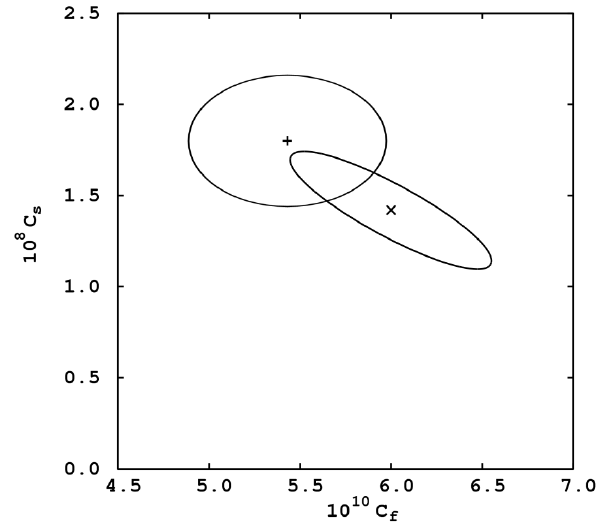
Figure A1. C s vs. C f for the R98 model ( + ) and its modification by Turner et al. (2009) ( × ), with uncertainty contours. Note the different scales on the two